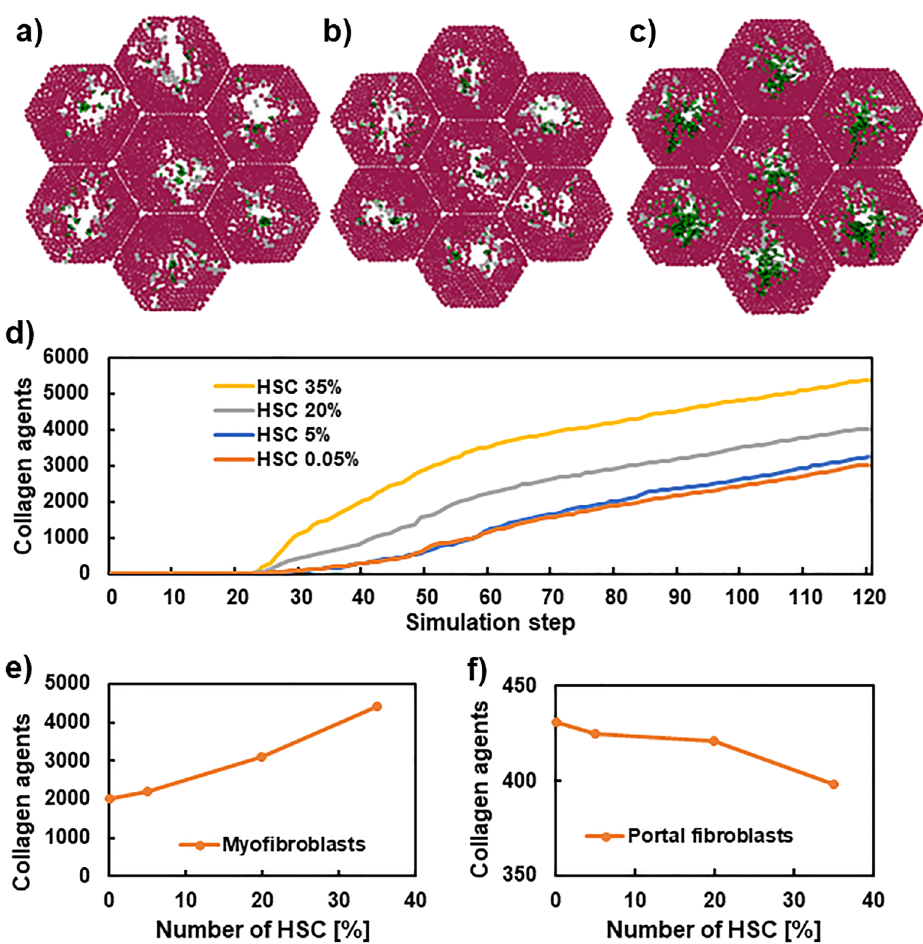
Figure 7. Comparison of simulated results with different initial HC cells. The 2-dimensional tissue sections at 40 steps ( a – c ). Hepatocytes (brown), dead cells (grey), and collagens secreted from myofibroblasts and portal fibroblasts (blue and green). The initial conditions before simulation are depicted in Fig. S2. Panel ( d ) shows the time-course of collagen agents with various initial HSC ratios. Panels ( e ) and ( f ) show the relationship between initial KC ratios and collagen agents produced from myofibroblasts and portal fibroblasts,